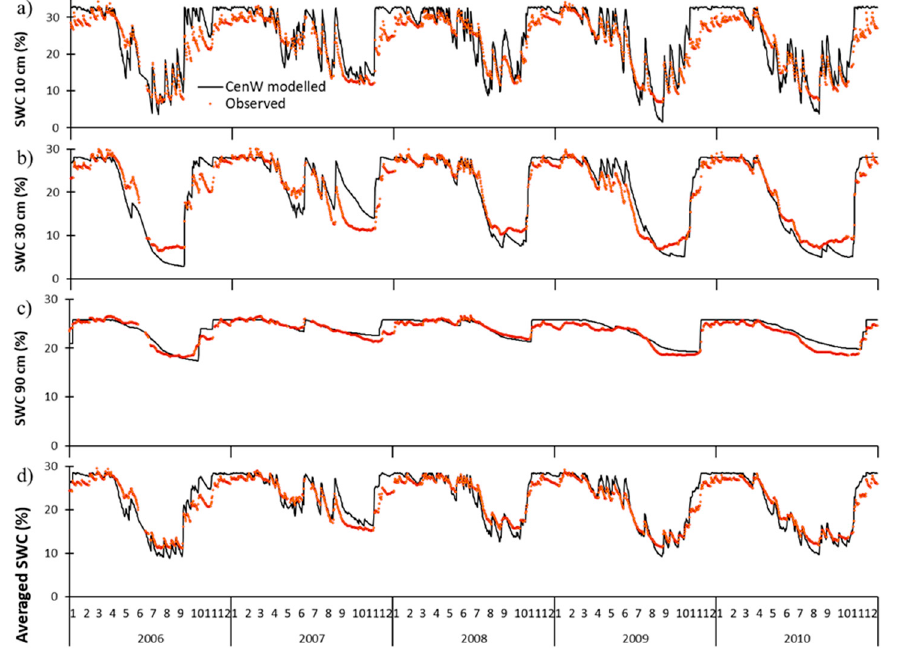
Figure 4. Time series of daily-modeled (black line) and observed (red symbols) soil water content at ( a ) 10 cm, ( b ) 30 cm, ( c ) 90 cm belowground, and ( d ) averaged over the whole soil profile (0–100 cm) for the mowed grassland. Agronomy 2019 , 9 , x FOR PEER REVIEW 13 of 32